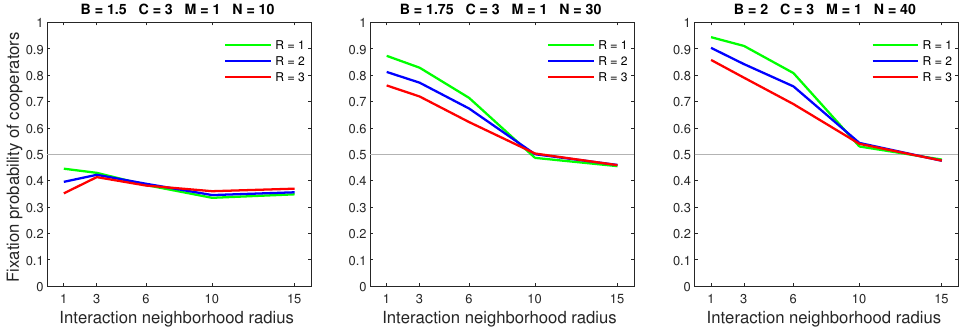
Figure 8. In the probabilistic dispersal model, increasing the dispersal range while keeping the mobility rate low ( M = 1) is primarily detrimental to cooperators in dense